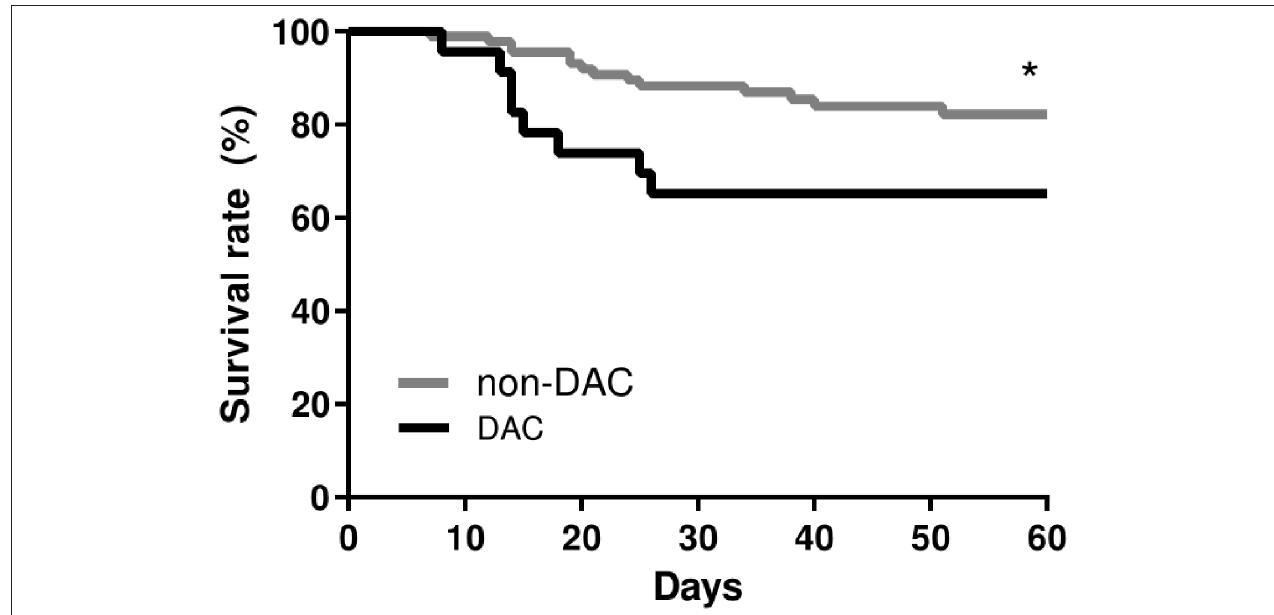
FIGURE 2 | Survival curve of patients with COVID-19. DAC, patients with self-reported DAC and COVID-19; Non-DAC, patients without DAC and COVID-19. * p < 0.05 difference. Comparison using the Log-rank (Mantel-Cox) test and the Gehan-Breslow-Wilcoxon test. Data collected between June 1, 2020 and December